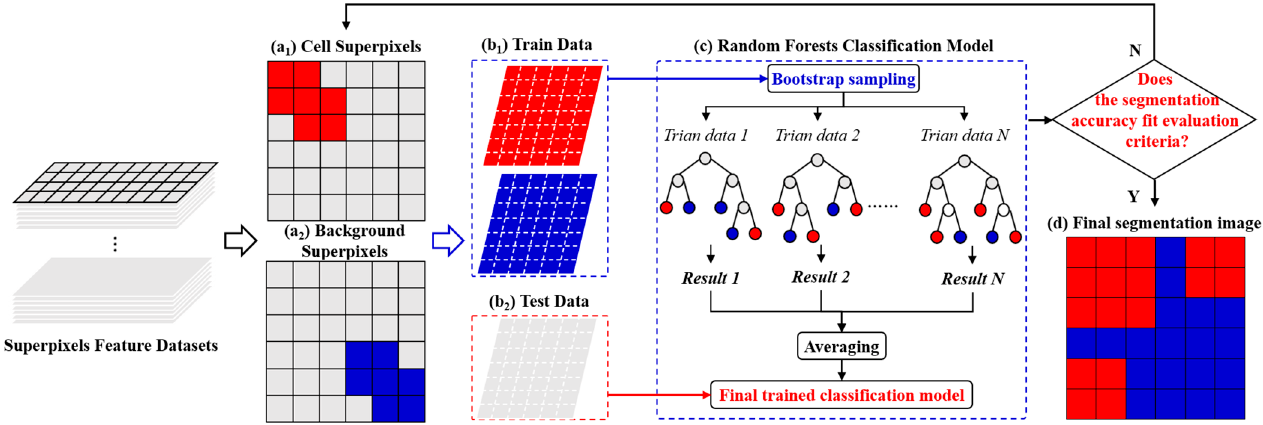
Figure 6. Flowchart of optimizable image semantic segmentation with RF classifier. ( a 1 ) and ( a 2 ) are the labeled cell and the background class superpixels of the image; ( b 1 ) and ( b 2 ) are the train data of labeled superpixels and test data of non-labeled superpixels of the image; ( c ) is the superpixels classifier based on the RF; ( d ) is the final segmentation